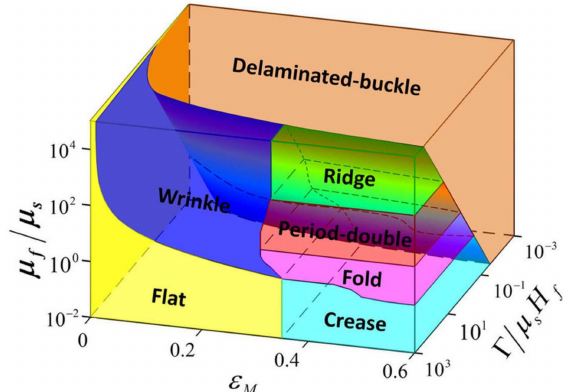
Figure 12. Phase diagram for thin surface layer (Wang and Zhao [46]). The ratio of moduli for the surface layer (e.g., domain wall in the present context) to that of the bulk is graphed versus strain (abscissa) and a thickness parameter (depth). Note that for most interesting phenomena, the surface layer must be stiffer than the substrate (ordinate modulus ratio >1); otherwise, the surface layer simply slides around without wrinkling or folding. Note also that the folding and period doubling regimes can be entered from the flat state via several trajectories in phase space, including stress ε M or increased surface domain wall (film) rigidity µ f . Reproduced from Wang and Zhao [46] under the terms